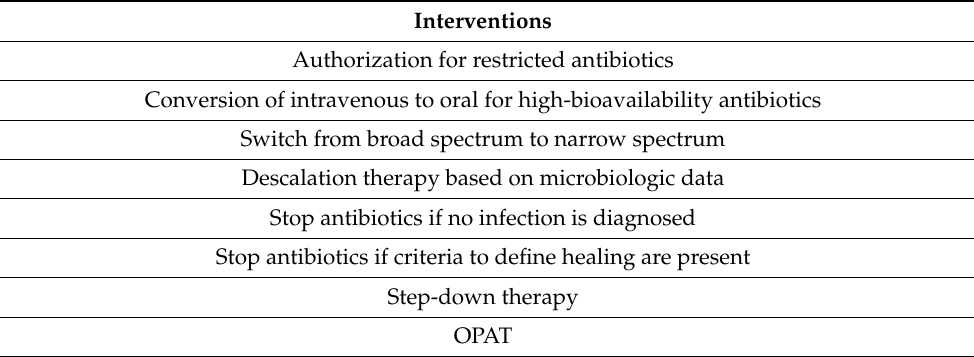
Table 3. The AMS interventions